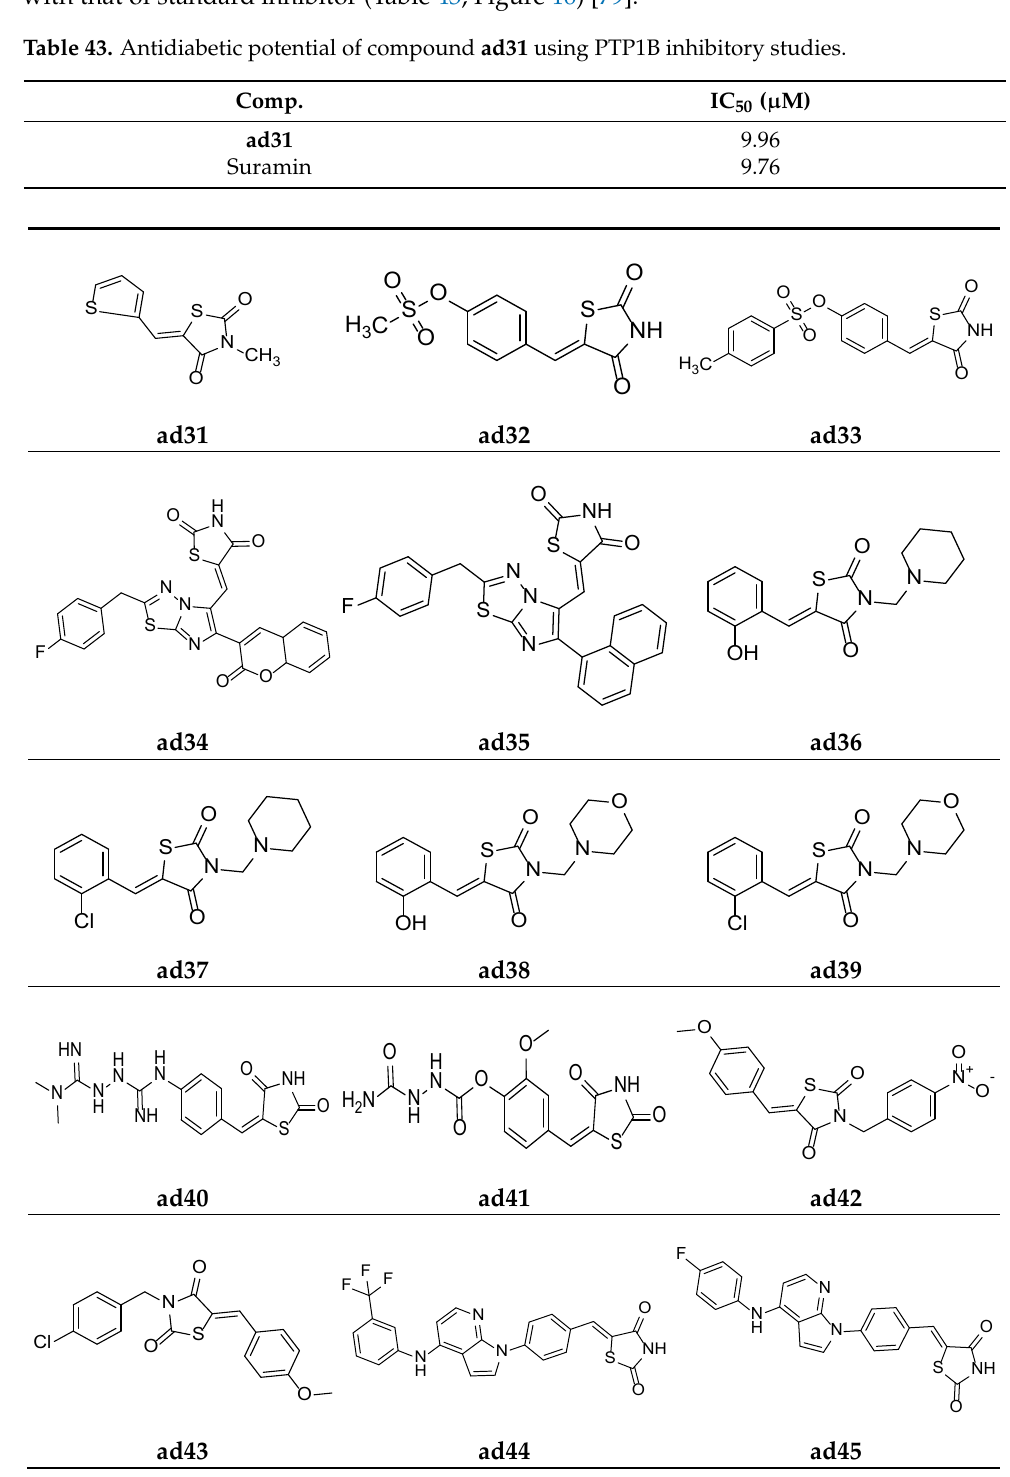
Figure 16. Molecular structures of the compounds ( ad31 – ad45 ).